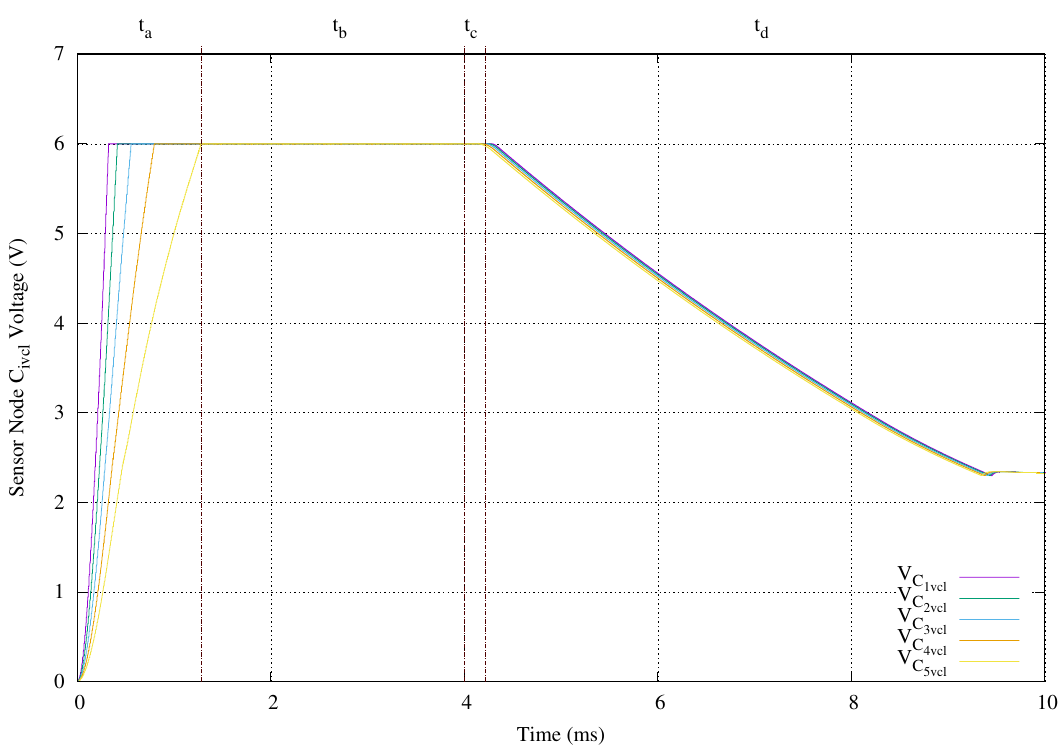
Figure 11. Charge capacitor voltage ( V C